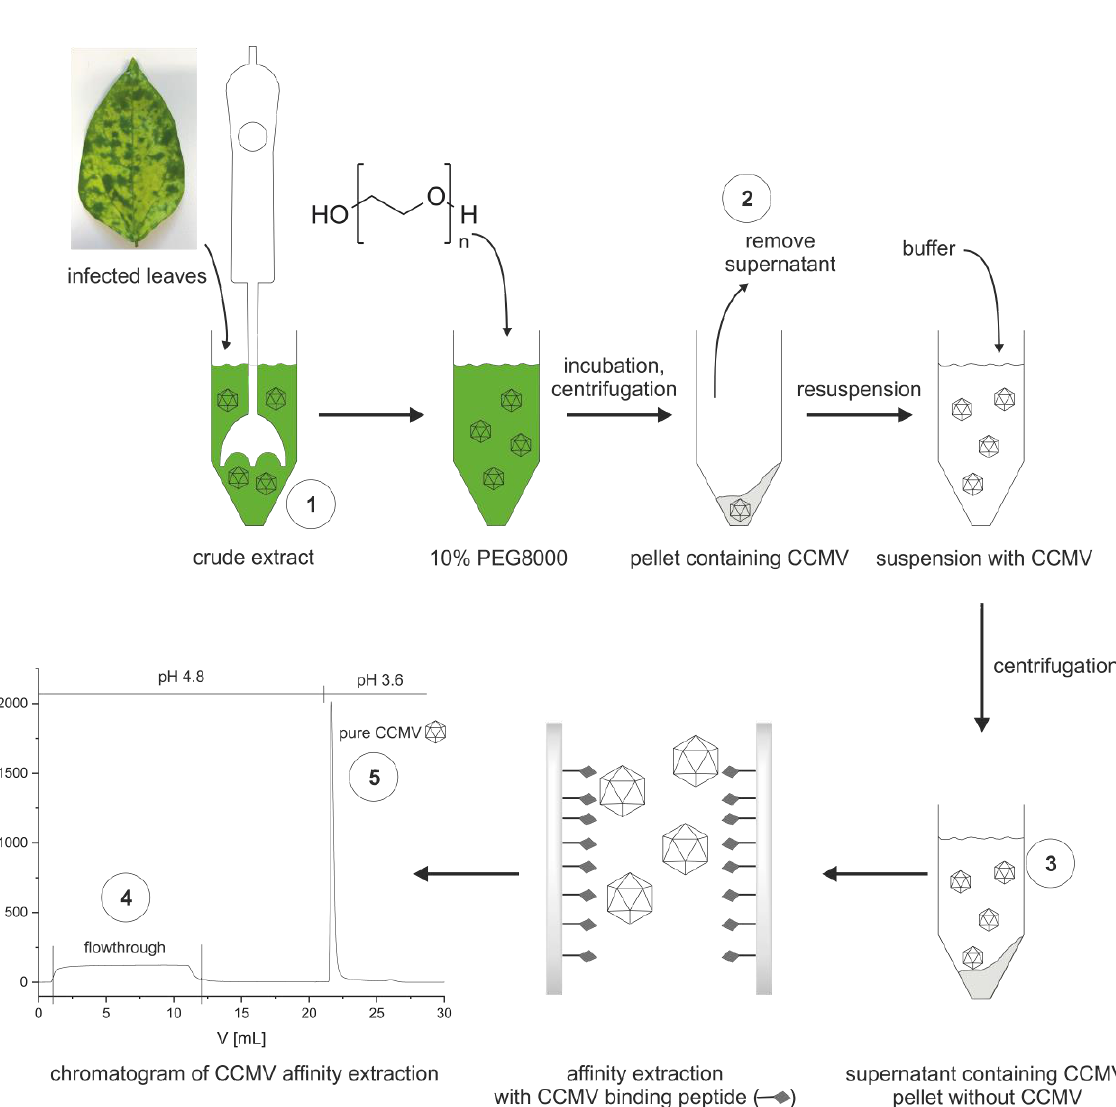
Figure 7. Optimized workflow for the purification of CCMV from leaves of Vigna unguiculata : Samples 1 (cid:13) to 5 (cid:13) are taken from the different purification steps. 1 (cid:13) Leaves are homogenized to a crude extract. The extract is centrifuged, and 10% PEG 8000 is added. After incubation overnight, the solution is centrifuged, and the supernatant 2 (cid:13) is removed. The pellet containing CCMV is completely resuspended with buffer. Afterward, the suspension is centrifuged again to obtain the essentially CCMV-free pellet. The supernatant 3 (cid:13) containing the CCMV, among other proteins and PEG 8000, is filtered. Pure CCMV 5 (cid:13) is isolated from the supernatant by affinity extraction with the CCMV binding peptide immobilized on a sintered glass monolith surface; the flowthrough of column 4 (cid:13) is